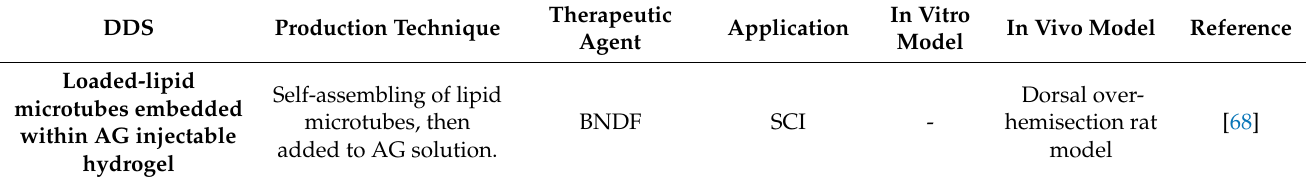
Table 4. Summary of Dx-based DDSs for SCI. DDS description, production technique, therapeutic agent delivered, and in vitro and in vivo models exploited for efficacy assessment are